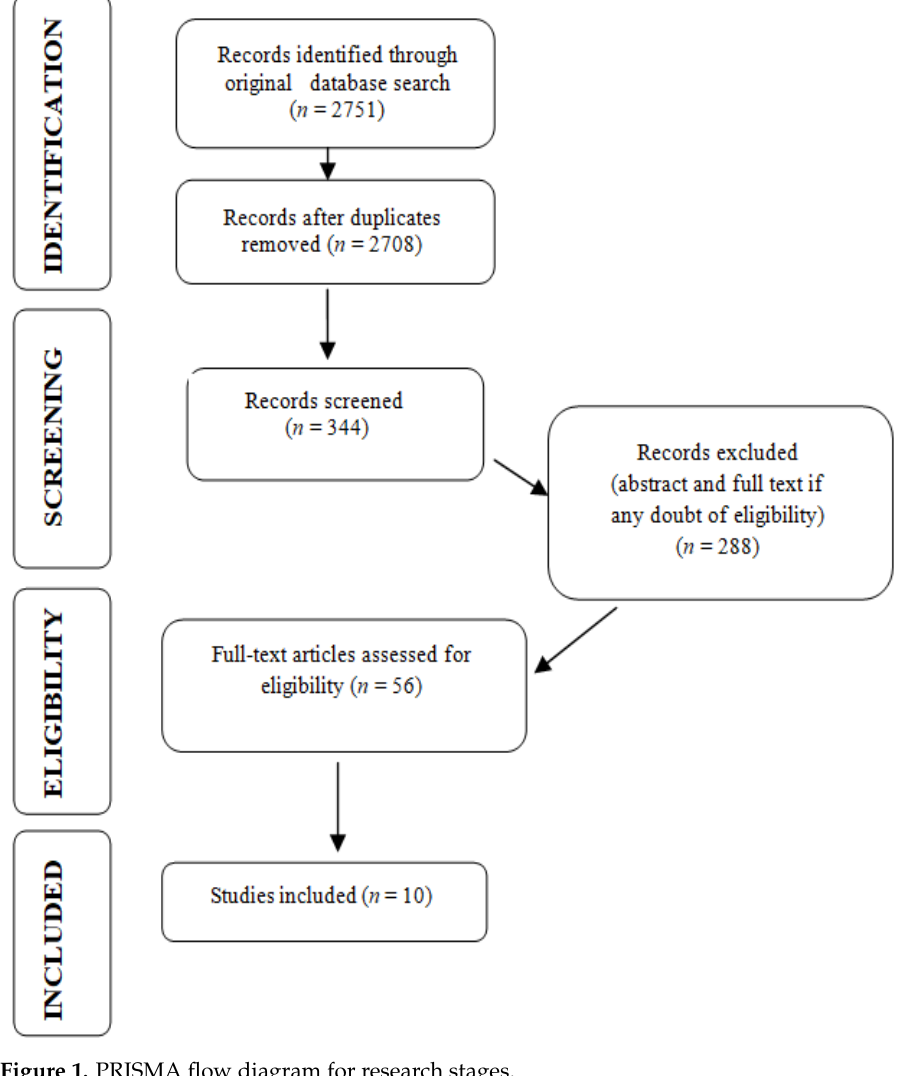
Figure 1. PRISMA flow diagram for research stages.